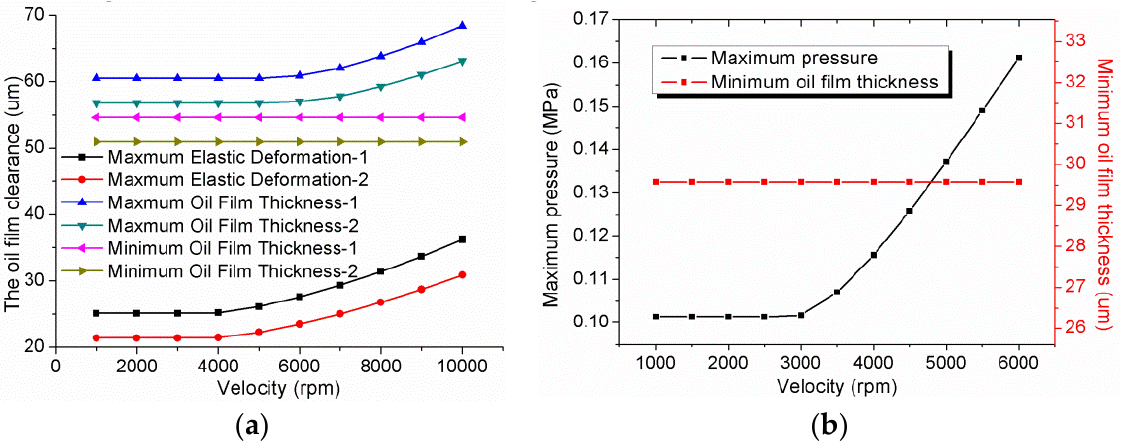
Figure 9. Effect of the velocity on the oil film clearance and pressure. ( a ) The oil film thickness and the elastic deformation with the velocity of rotation; ( b ) the minimum oil film thickness and maximum pressure with the velocity of rotation.